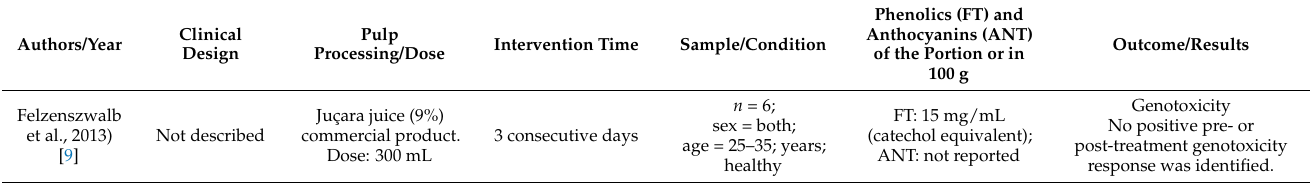
Table 2. The inflammatory modulation, antioxidant defense, prebiotic potential, genotoxicity, epige- netic regulation, and metabolic effects after consumption of juçara in clinical trials according to the scientific